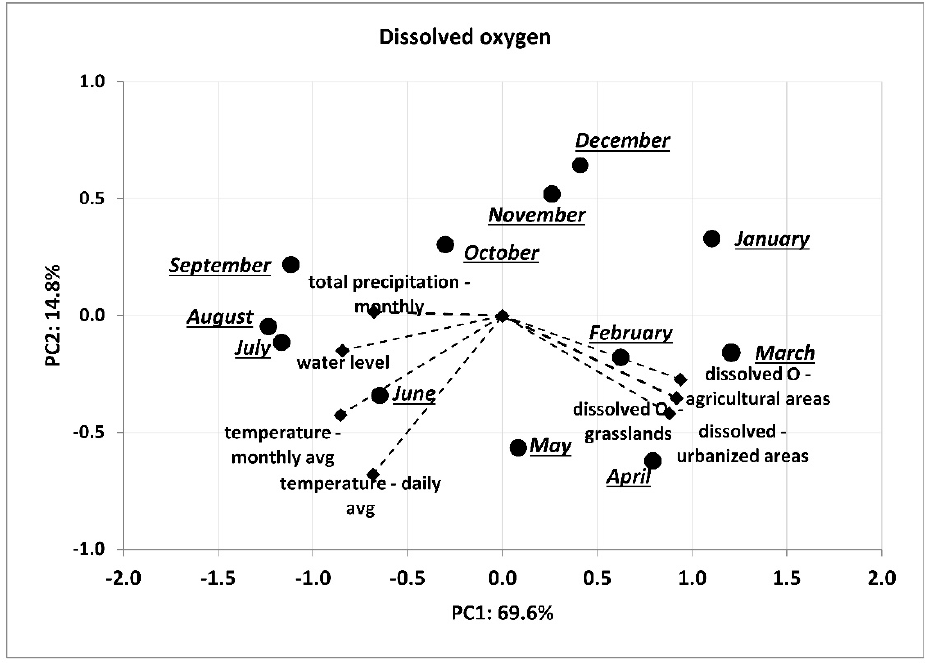
Figure 11. PCA analysis for the relationships between: catchment area land use, weather conditions and dissolved oxygen concentration in the Utrata River.